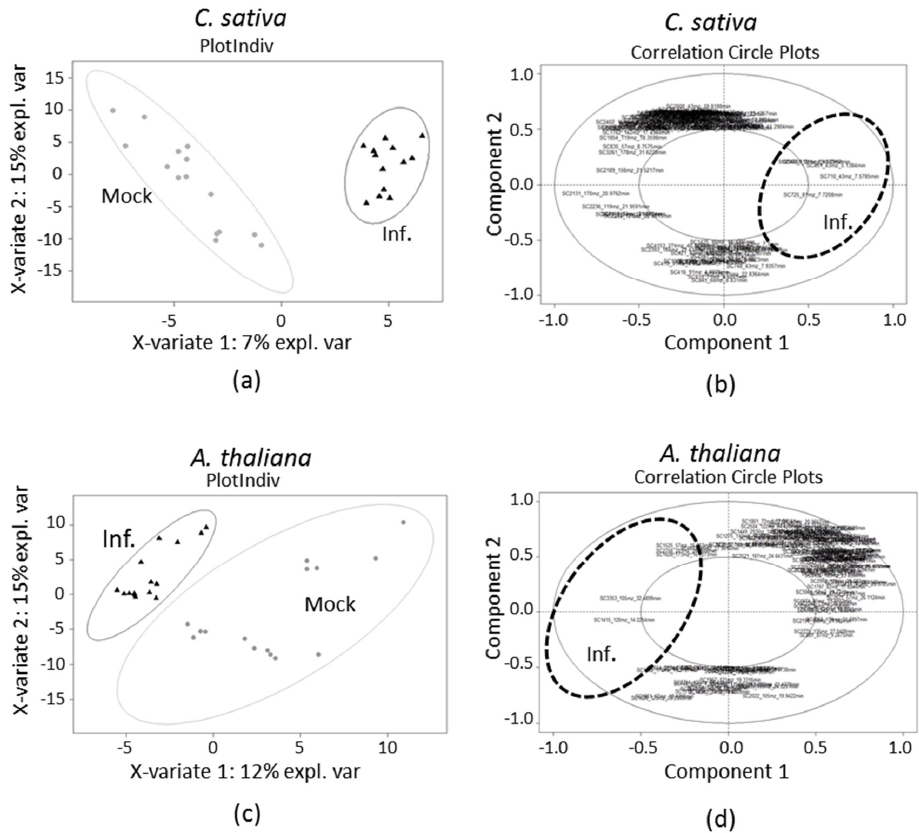
Figure 3. Multivariate analysis using partial least-square discriminant analysis (PLS-DA) of volatile organic compounds (VOC) profiles emitted from C. sativa ( a , b ) and A. thaliana ( c , d ) TuYV-infected and non-infected plants. ( a , c ): PLS-DA sample plots. Each symbol represents two plants for C. sativa and seven plants for A. thaliana . Black triangles stand for TuYV-infected plants and grey circles for mock-inoculated plants. Confidence ellipses for each group are plotted to highlight the strength of the discrimination (confidence level set to 95%). ( b , d ): PLS-DA correlation circle plots. The variables (volatiles) are represented through their projections onto the plane defined by the first two dimensions on the correlation circle of radius 1. A threshold of 0.5 is set to remove weaker correlations and to plot only volatiles with major importance. Strongly correlated variables are projected in the same direction from the origin. The distance from the origin is correlated to the strength of the association. The dashed ellipses tentatively highlight the metabolites which are the most correlated with infection of C. sativa ( b ) and A. thaliana ( c ).